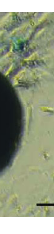
Figure 1: Detection of surface markers, osteogenesis, adipogenesis, and cartilage-induced di ff erentiation of HUCMSCs. FACS was used to detect the surface markers, and ICC was used to detect the di ff erentiation. (a – c) The expression of positive surface marker CD73, CD90, and CD105. (d – h) The expression of surface negative markers CD14, CD19, CD34, CD45, and HLA-DR. (i) The osteogenic di ff erentiation was analyzed by Alizarin Red staining. (j) The adipogenic di ff erentiation was analyzed by Oil Red O staining. (j) The chondrogenic di ff erentiation was analyzed by Alcian Blue staining. The scalebar = 20 μ m in (i, j) and 100 μ m in (k). Hematoxylin & eosin r n t o C